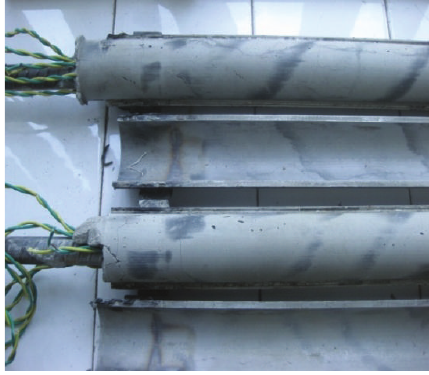
Figure 10: Damage of anchor.